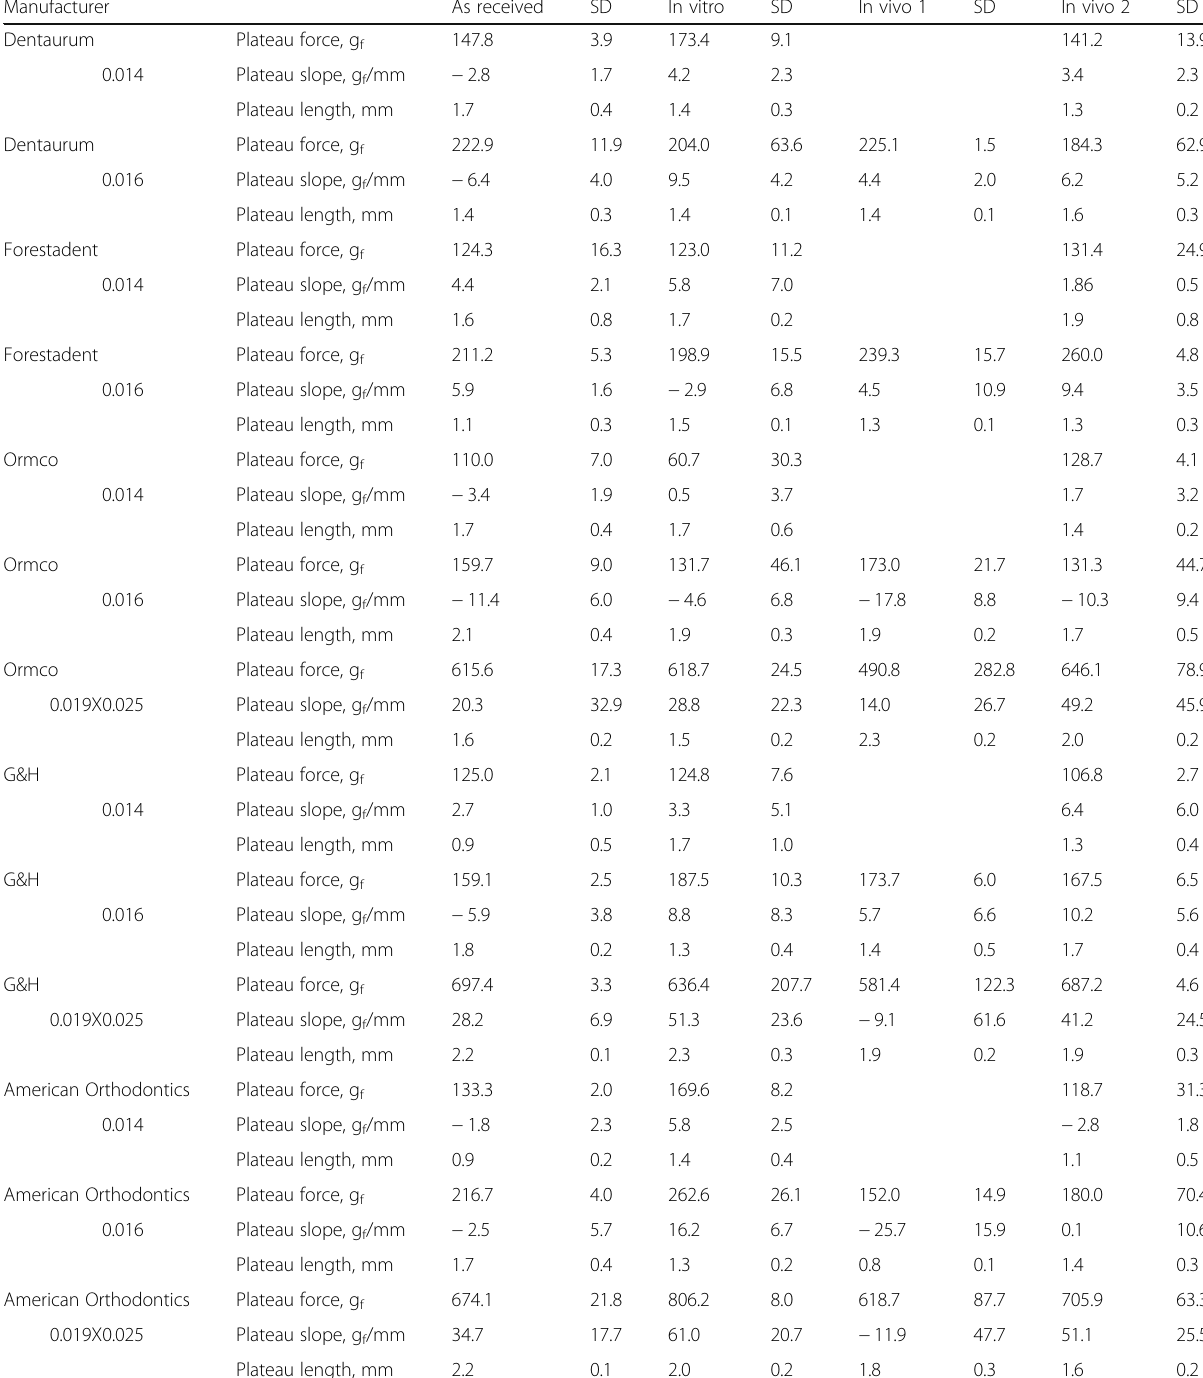
Table 2 The mean values yielded by as received and retrieved traditional orthodontic wires